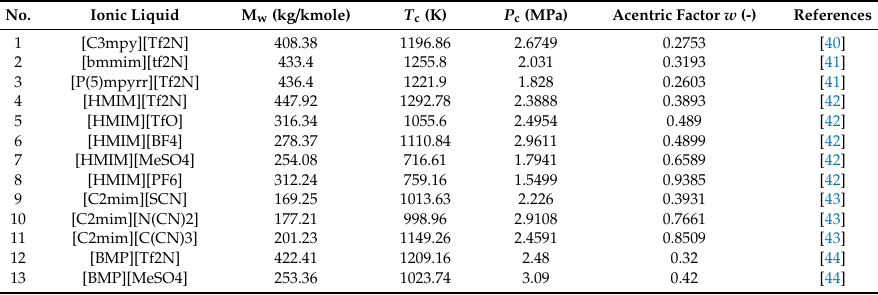
Table 2. Thermodynamic properties of ionic liquids (ILs) used in this study.